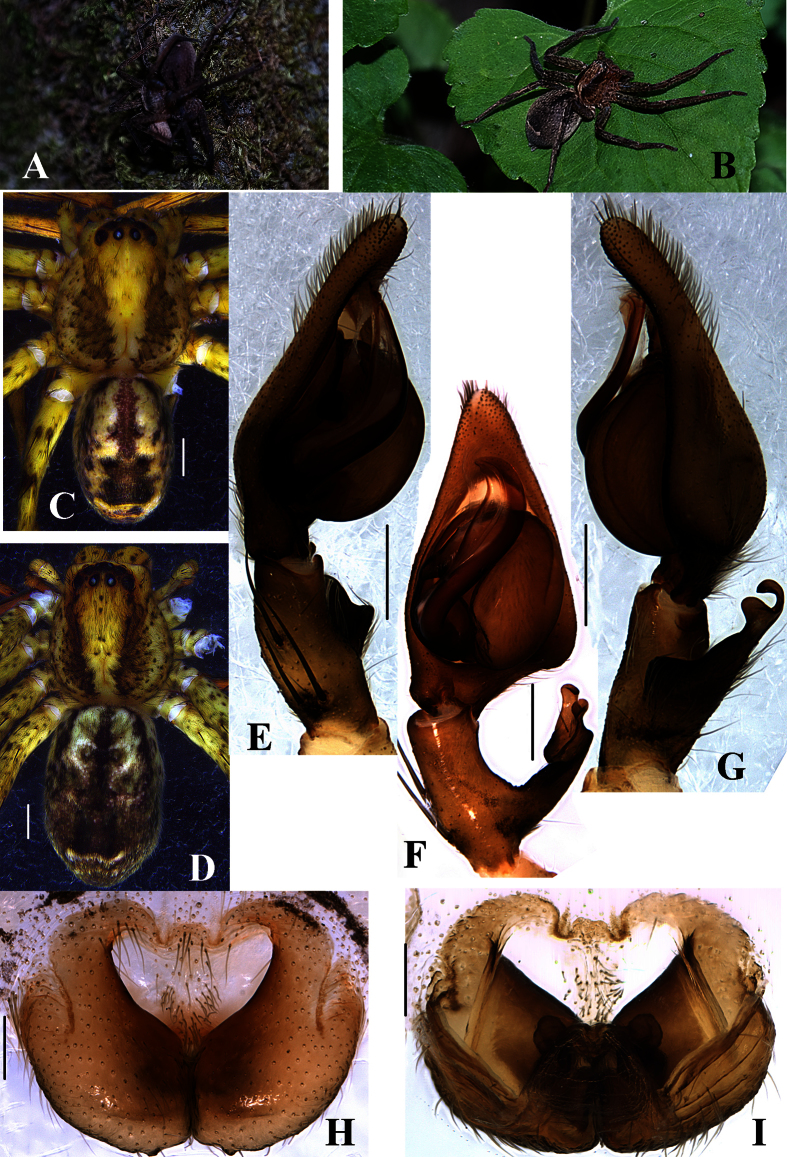
P. yunnanensis qss in field and its morphological details.(A) P. yunnanensis qss mating; (B) P. yunnanensis qss on leaf; (C) Male habitus, dorsal view; (D) Female habitus, dorsal view; (E) Male palp, prolateral view; (F) Male palp, ventral view; (G) Male palp, retrolateral view; (H) Epigyne, ventral view; (I) Vulva, dorsal view. Scale bars: (C, D) = 1 mm; E-I = 0.2 mm.